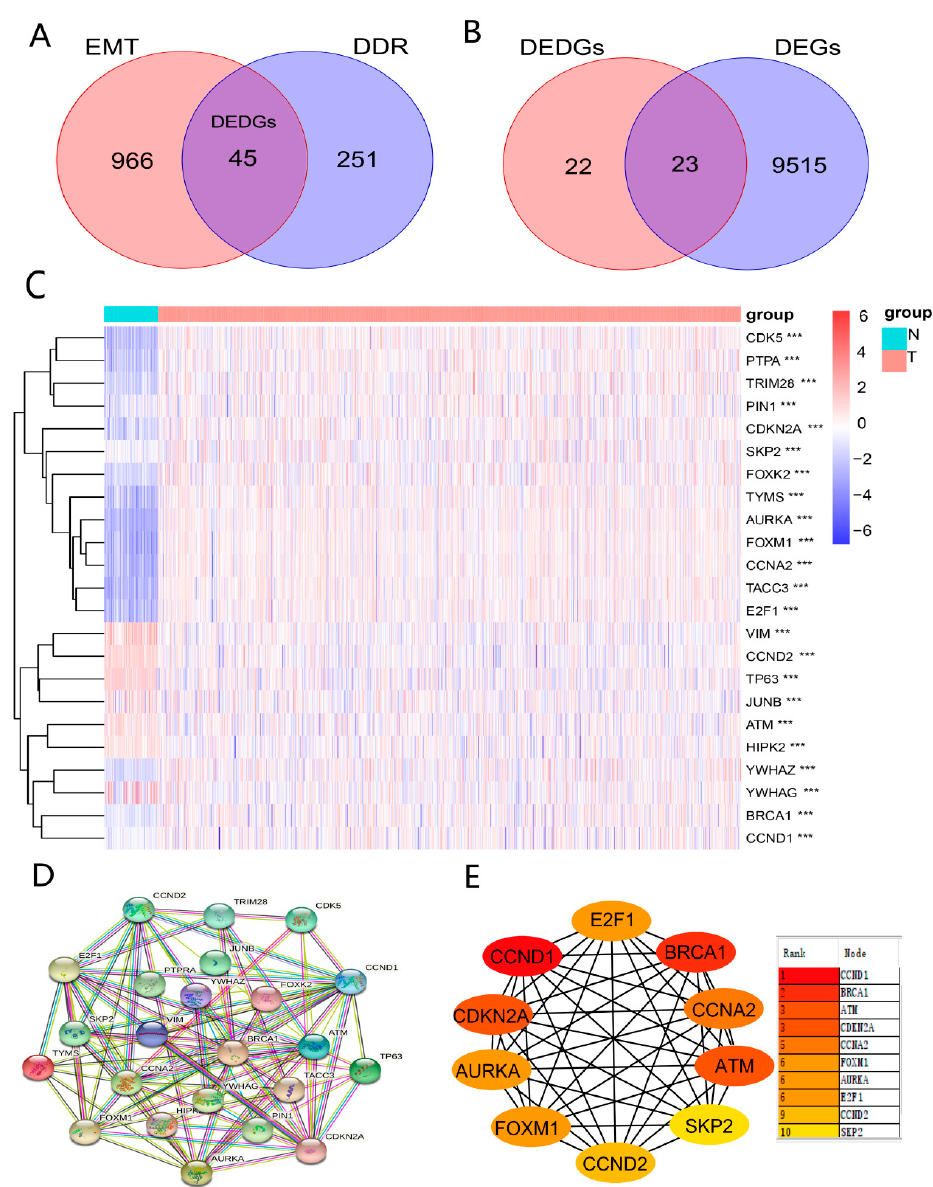
Figure 2. Identification of DEDGs with both EMT and DDR functions: ( A ) Venn diagram showing the intersecting genes (DEDGs) between EMT and DDR; ( B ) Venn diagram presenting the intersecting genes between DEDGs and DEGs; ( C ) heatmap of 23 DEDGs between TCGA-BRCA and normal samples (blue: low expression level; orange: high expression level; *** p < 0.001); ( D ) protein–protein interaction (PPI) network of 23 DEDGs (interaction score = 0.4); ( E ) 10 hub genes based on the PPI results.